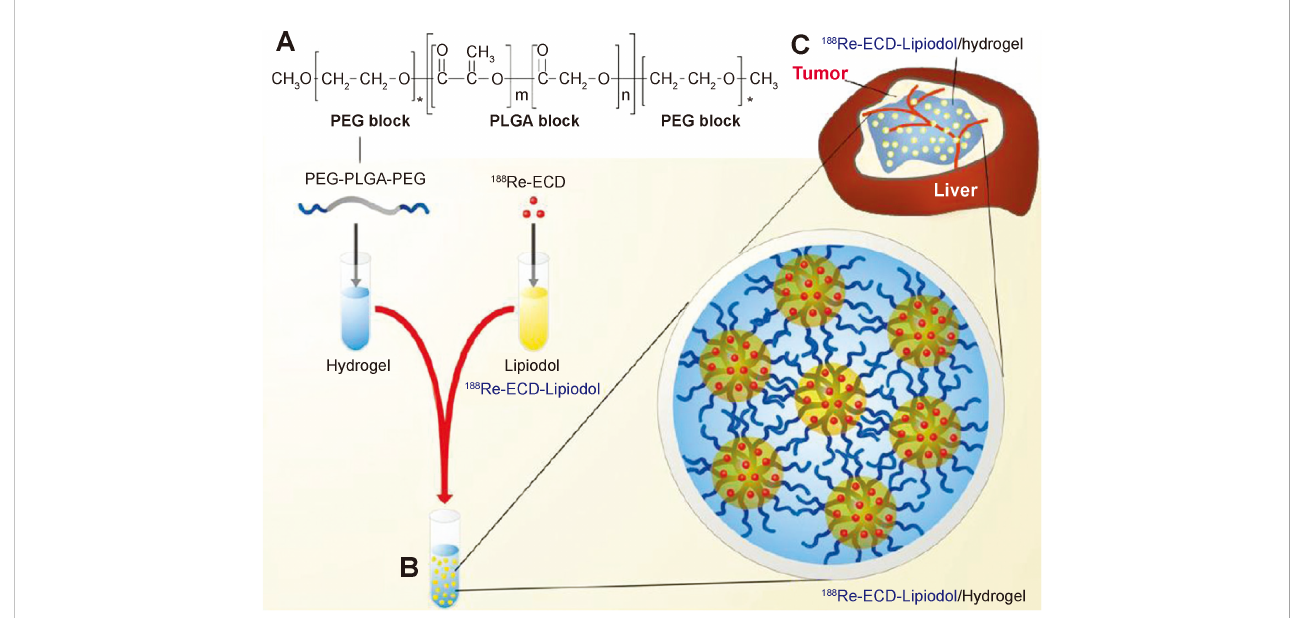
FIGURE 3 PEG-PLGA-PEG chemical structure, preparation of 188 Re-ECD-Lipiodol/hydrogel, and hepatoma animal model treatment. (A) Chemical structure of PEG-PLGA-PEG. (B) Optical images of 188 Re-ECD-Lipiodol/hydrogel, prepared by mixing PEG-PLGA-PEG (30% w/w) and 188 Re-ECDLipiodol in a 1:1 ratio. (C) 188 Re-ECD-Lipiodol/hydrogel was administered to N1-S1 hepatoma-bearing rats via intratumoral injection